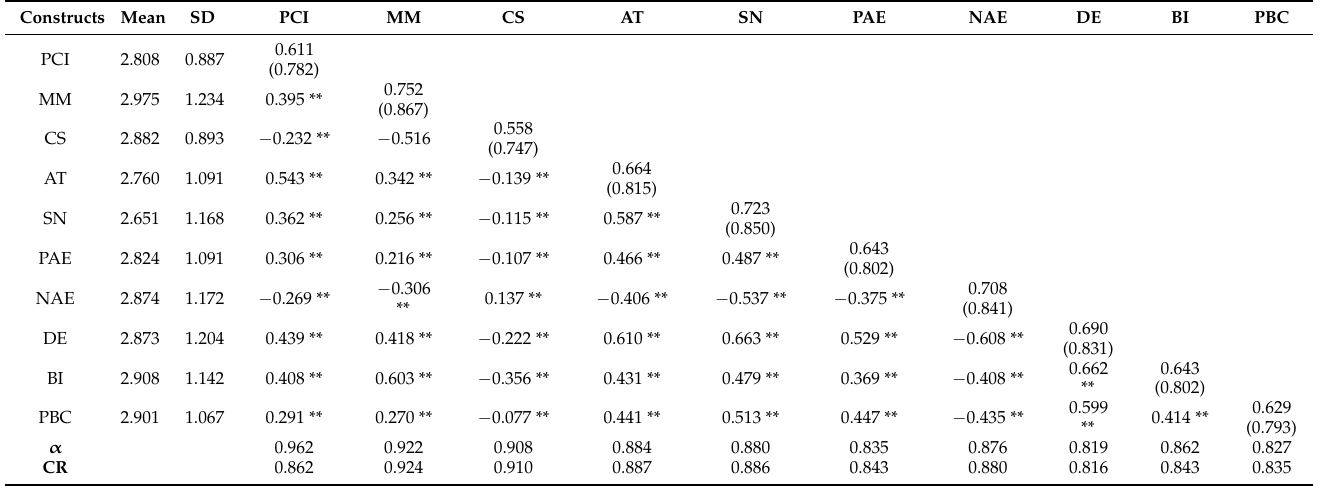
Table 4. Means, SD (standard deviations), and correlations of the